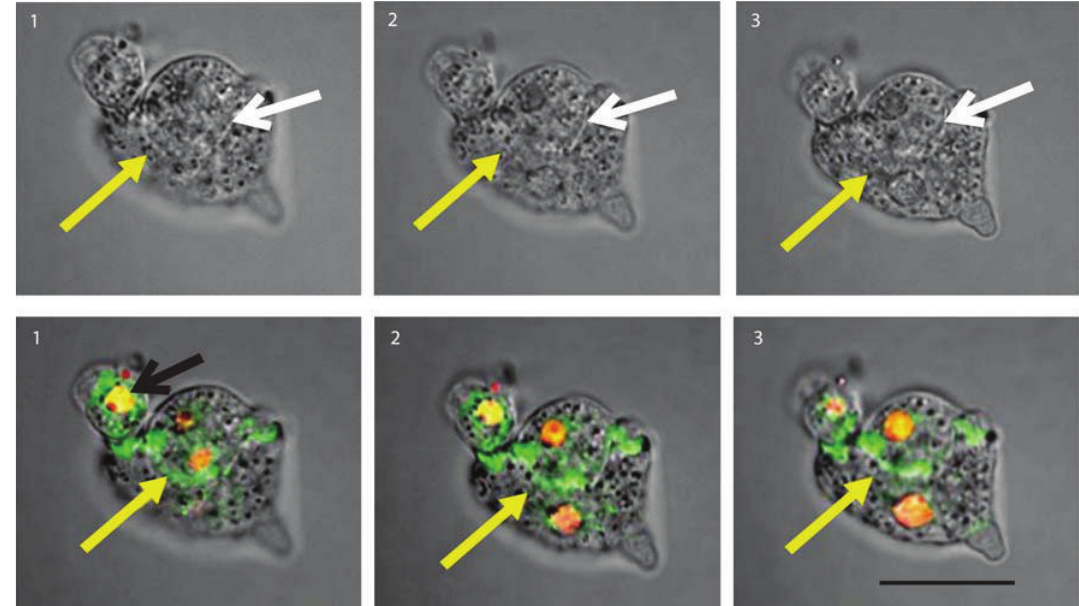
Figure 2: Behavior of ZYG1 during cell fusion. GFP/ZYG1 OE cells were starved for 2 h and fixed with methanol for 10min. Pictures of their serial sections (1 ∼ 3:4 μ m thick) were taken under a confocal microscope. Pictures on the upper side show DIC images and those on the lower side the merged images of DIC, GFP, and DAPI staining. The color of DAPI staining is shown as red. In the DIC images (upper panels), the boundaries shown by white arrows are clear in all sections. On the other hand, the boundary shown by a yellow arrow is clearly observed in section 1, while the demarcation becomes unclear in sections 2 and 3. This indicates that the two cells are fusing around here (2, 3). In merged images (lower panels), GFP/ZYG1 fusion protein is localized at the region of cell fusion (2, 3; yellow arrows). Nuclei become yellow by merging GFP with DAPI staining. Bar: 20 μ m.